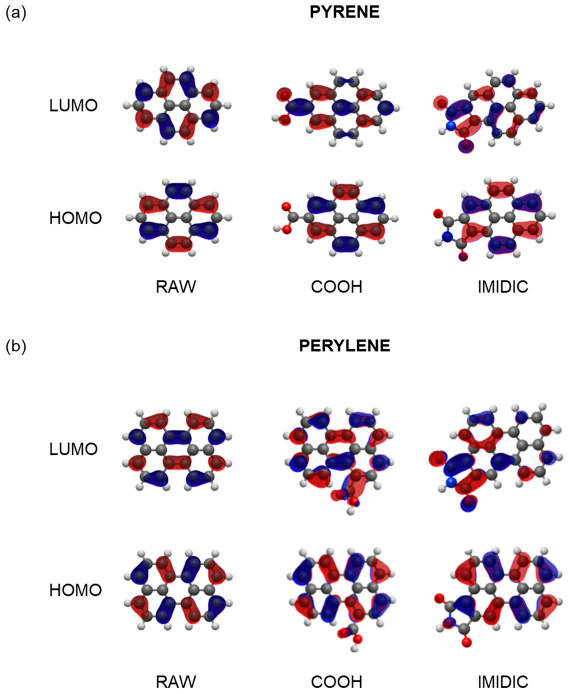
Figure 8. Natural Transition Orbitals (NTOs) for HOMO and LUMO states in the case of pyrene ( a ) and perylene ( b ) most representative models. The isocontour value is 0.03 au. The phase of the wavefunction is represented by red and blue colors.